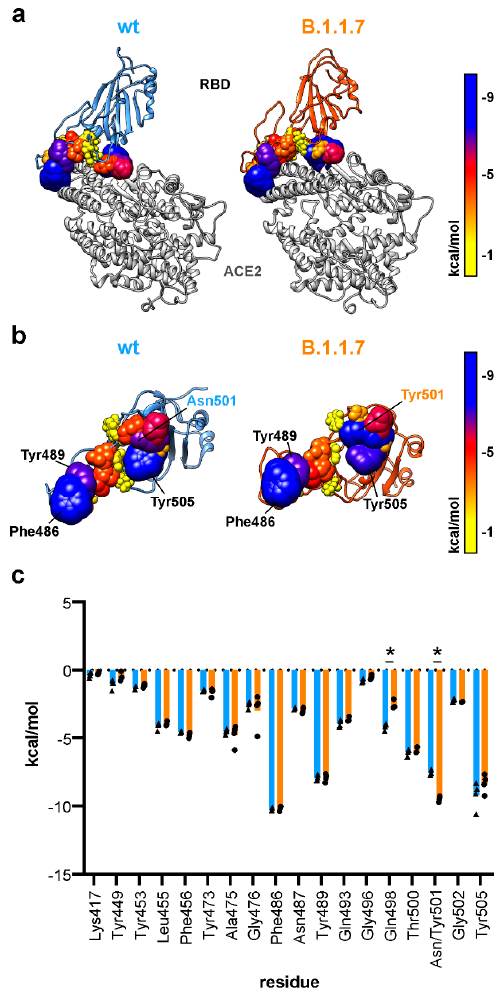
Figure 4. Van der Waals linear interaction energy between the RBD and ACE2. ( a ) Structural representation of the RBD (wild type, wt: blue; B.1.1.7: orange) in complex with ACE2. RBD residues with atoms within a maximum distance of 4 Å from ACE2 are shown as spheres with radii and colors according to their van der Waals linear interaction energy to ACE2. ( b ) View of the interacting interface of the RBD with ACE2. Residue color and atom size represent the van der Waals linear interaction energy to ACE2. ( c ) Quantification of van der Waals linear interaction energy for all RBD residues within 4 Å distance of ACE2 ( n = 4; two-way ANOVA; statistical significance assumed for * p < 0.05; full list of results in Table